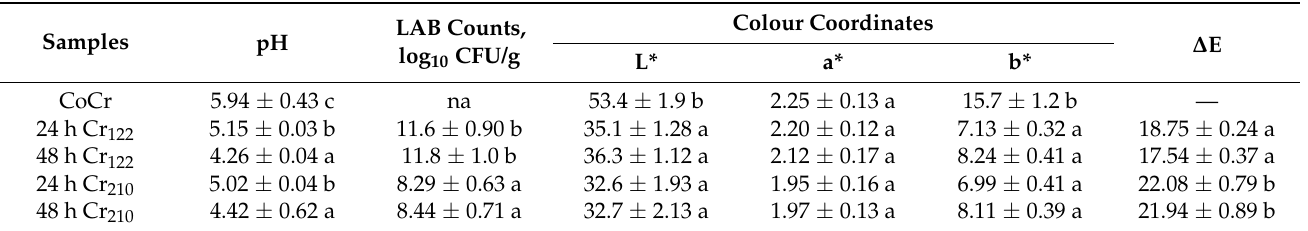
Table 1. pH, lactic acid bacteria (LAB) counts, colour coordinates and total colour difference ( ∆ E) of fermented and non-treated cricket flour